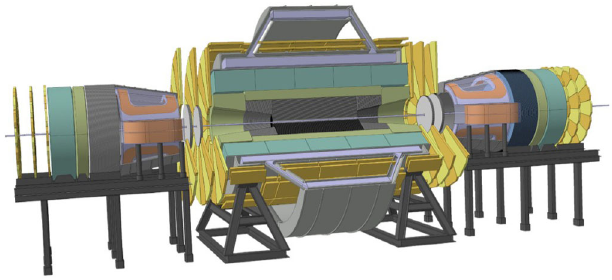
FIG. 1. Twin solenoid detector with forward dipoles detector layout. Also shown are the hadron calorimeters in dark green, the electromagnetic calorimeters in light green, the trackers in grey, and the muon chambers in